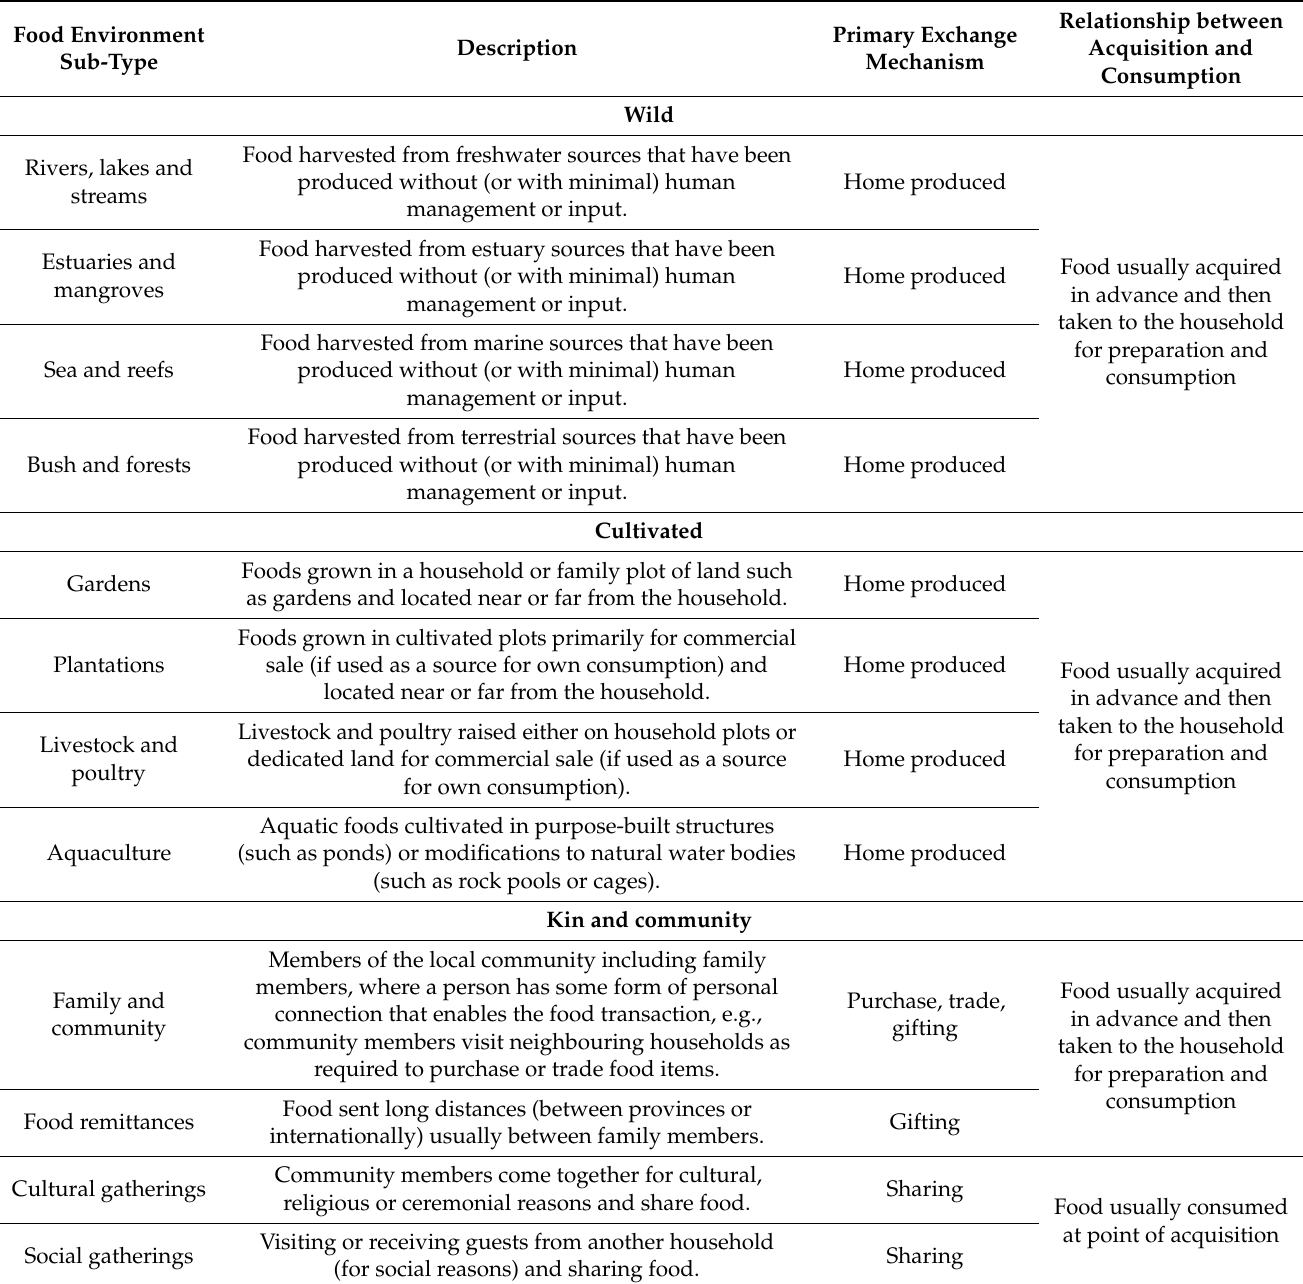
Table 1. Definitions of food environment sub-types in the